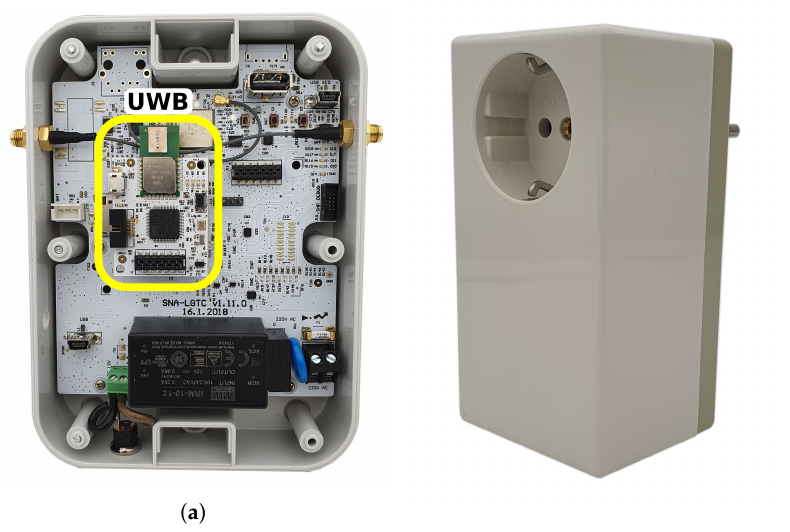
Figure 1. ( a ) UWB extension card integrated in EGW device. ( b ) Standalone UWB socket-on- socket